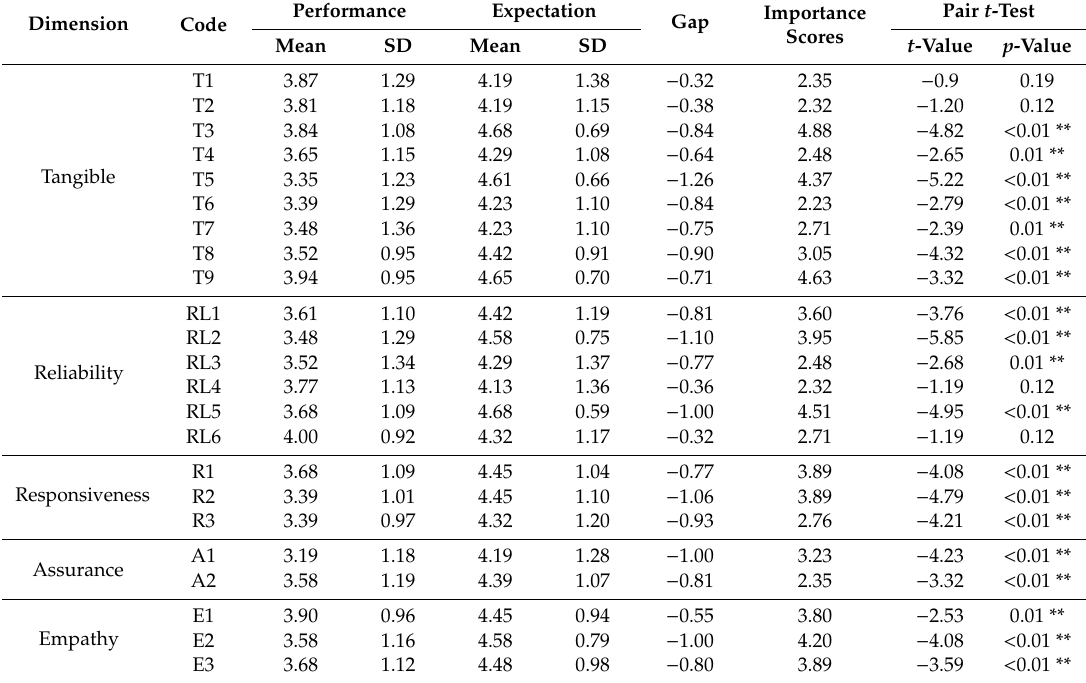
Table 4. The results of SERVQUAL